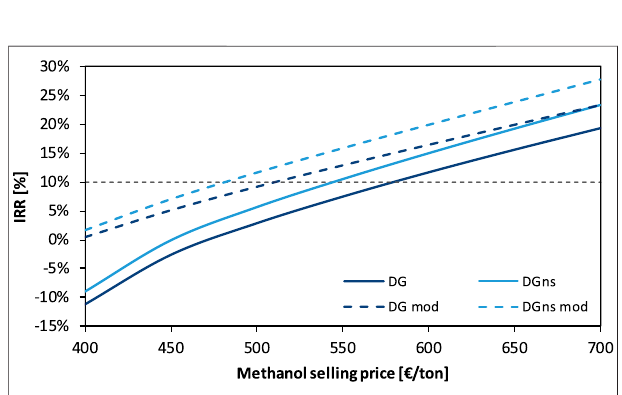
FIGURE 11 | IRR of the DG and DGns based plants as a function of the methanolsellingpriceforanelectrolyzerinvestmentcost of400 € /kW.Curves are derived from the two electricity price curves shown in Figure 9